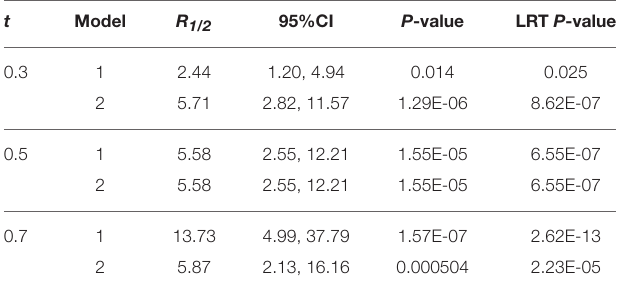
TABLE 3 | Relative risk with 95% CI, P -values, and likelihood ratio test P -values of models 1 (Unadjusted) and 2 (Adjusted) for a high penetrance rare